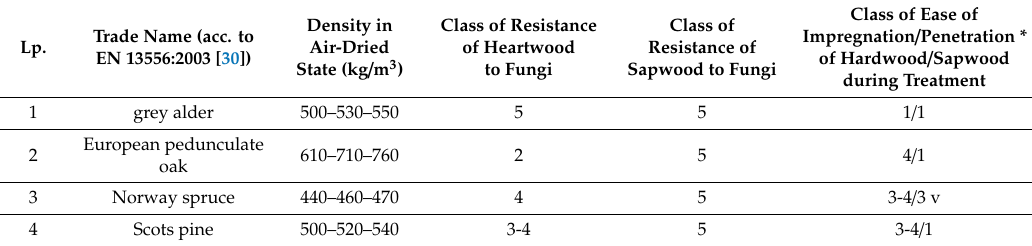
Table 2. Natural resistance of selected types of wood to fungi—five-step classification and ease of impregnation in accordance with the data in EN 350:2016